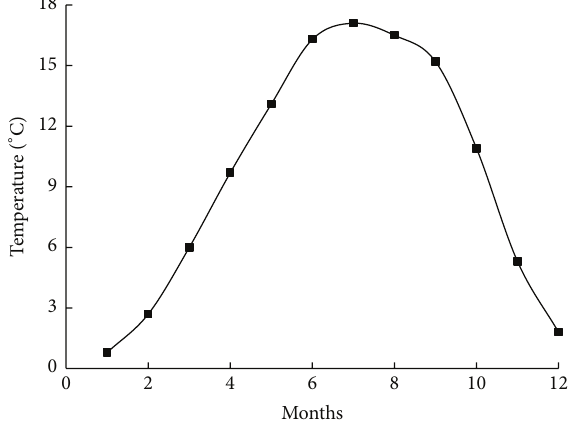
Figure 7: Annual average temperature variation of river